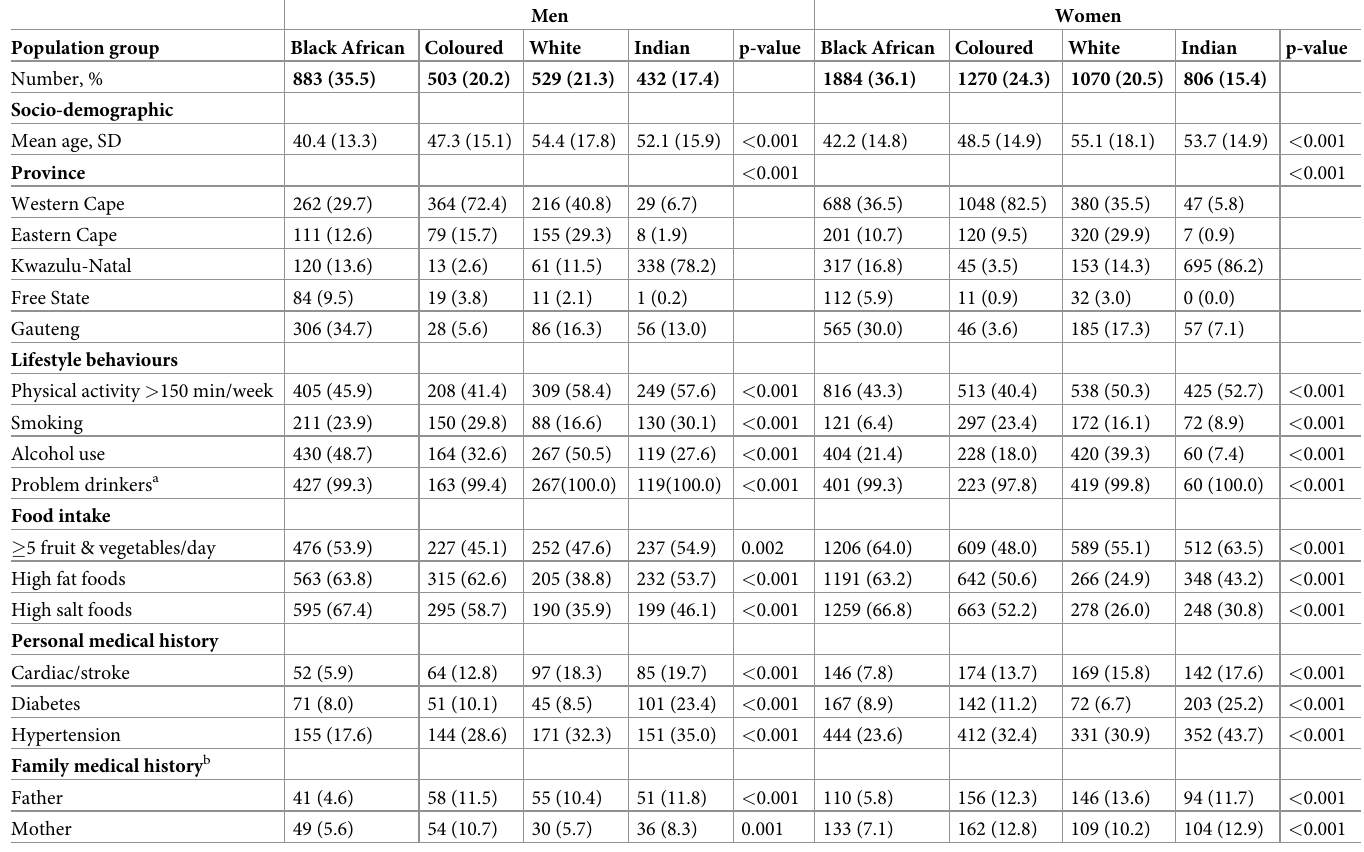
Table 1. Socio-demographic characteristics (N, %), lifestyle behaviours and medical history presented by population group and gender. Men